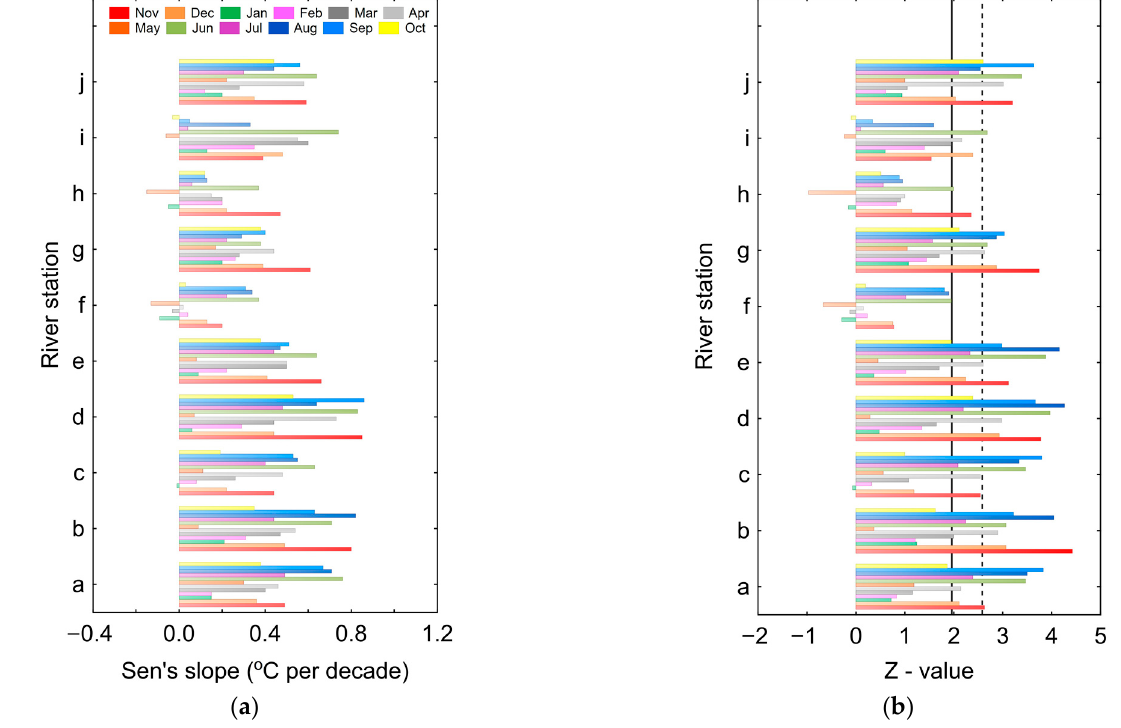
Figure 4. Changes in mean monthly river water temperatures: ( a ) Rate of changes in °C per decade and ( b ) significance of the changes (solid line—significance level of 0.05, dashed line—significance level of 0.01).